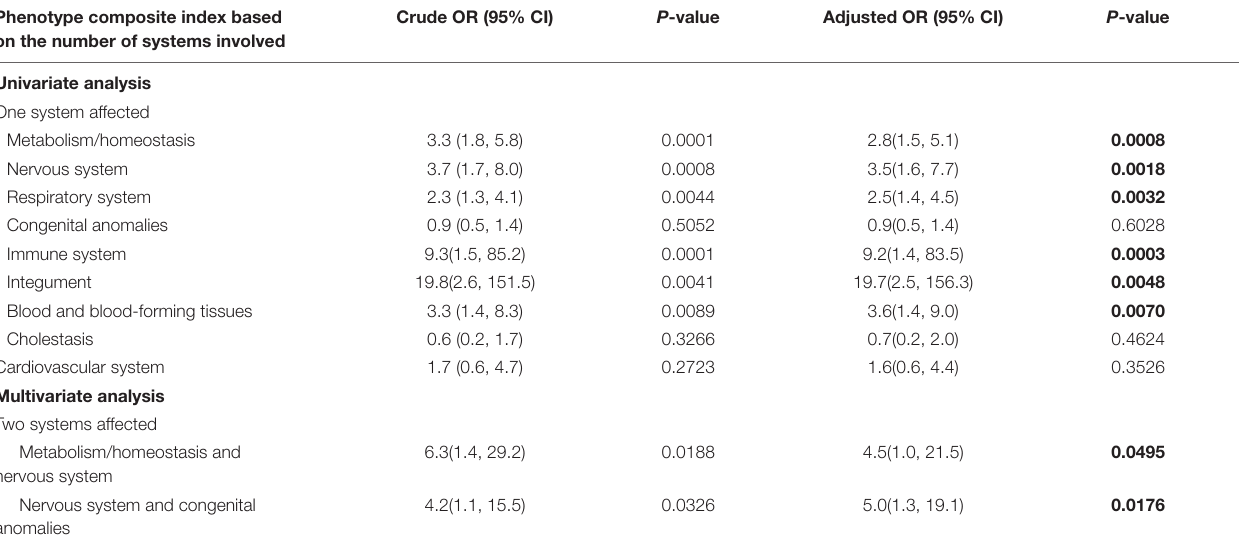
TABLE 2 | Unadjusted and adjusted odds ratios of clinical phenotypes and mixed phenotypes for identification of individuals with a molecular diagnosis. Phenotype composite index based Crude OR (95% on the number of systems involved